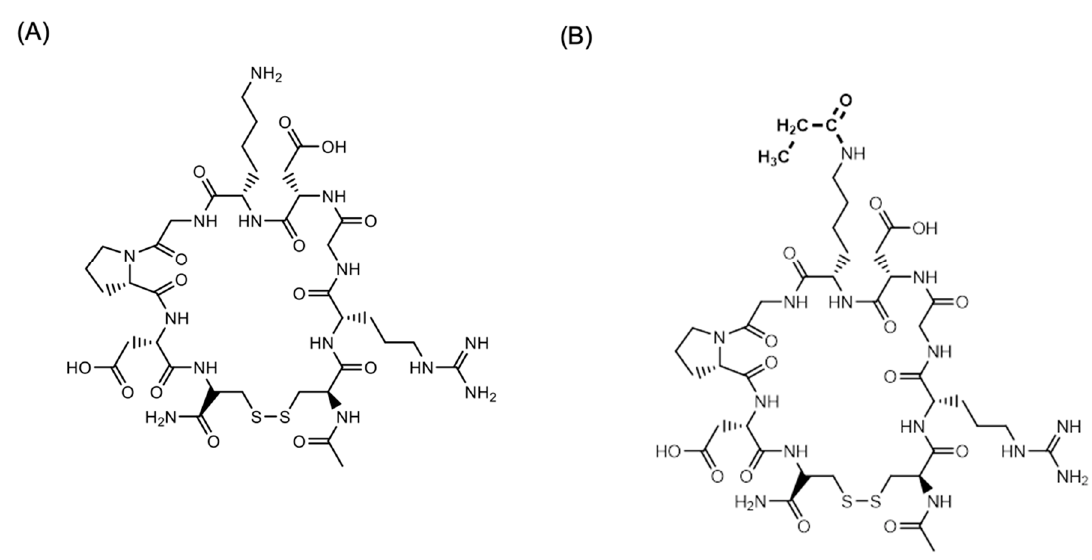
Figure 7. Structure of ( A ) CEND-1 and ( B ) [ 3 H]-CEND-1. In ( B ) the H atoms of the acetyl group were the 3 H. the 3